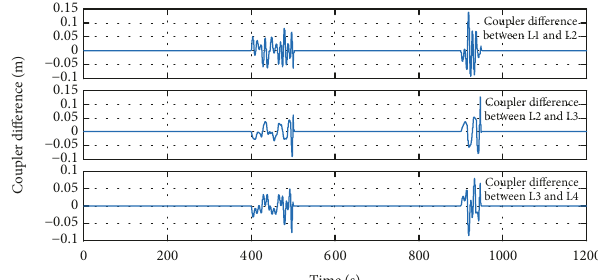
Figure 7: The coupler deformation between two neighbouring locomotives in Scenario A.